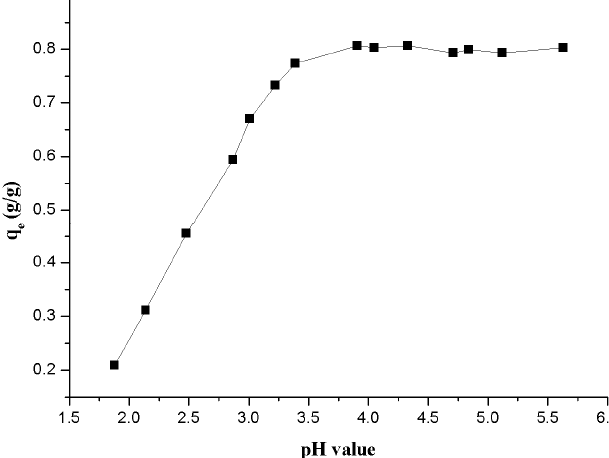
Figure 6. Effect of the pH value of the solution on the adsorption of Th(IV) onto β -CD(AN- co -AA). ([Th(VI)] 0 = 6.5334 × 10 − 4 M, m/V = 0.18 g/L, T = 298.15 ± 1.00 K, I = 0.50 M NaNO 3 ).